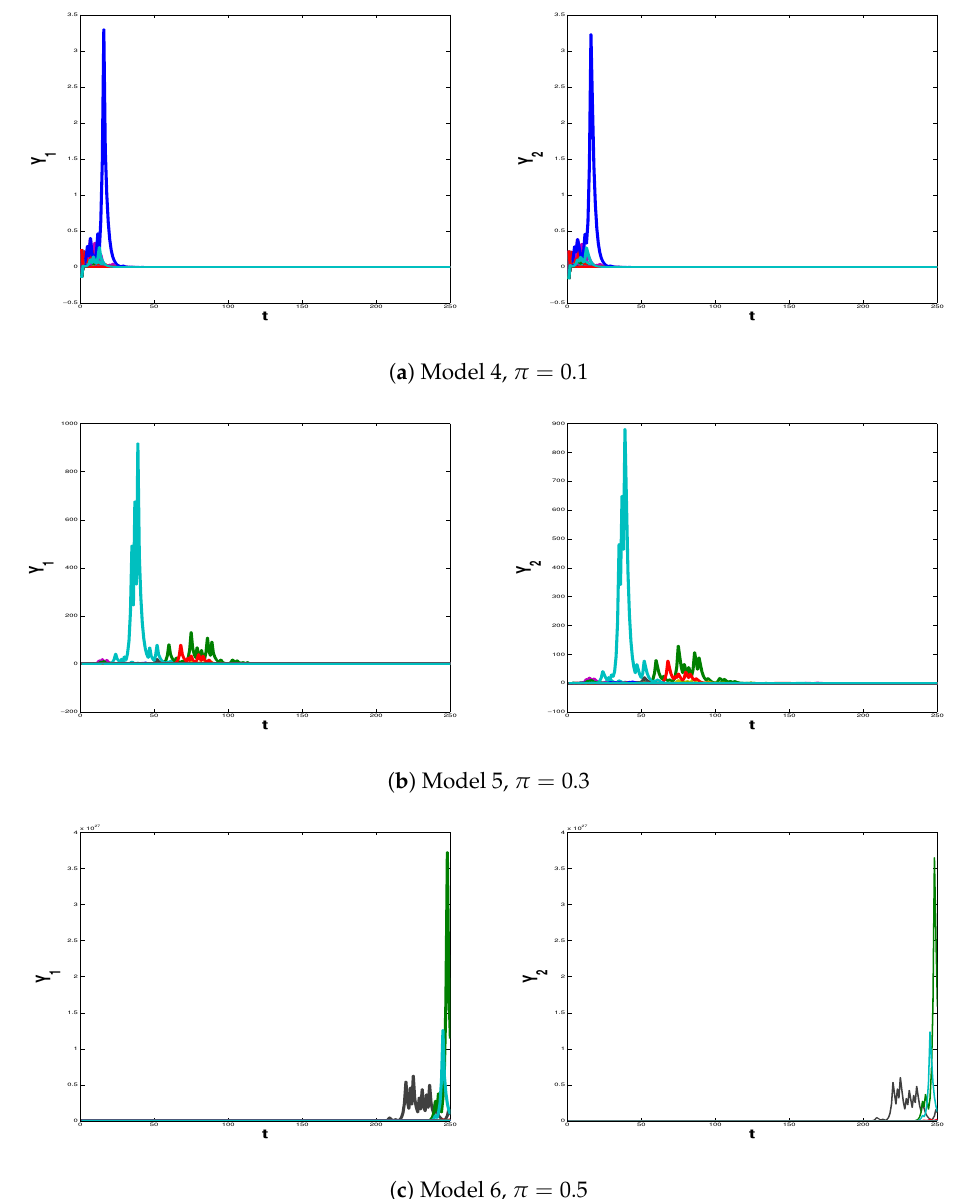
Figure 2. Simulated paths represented by different colors from models 4–6 for different set of histories over a n = 250 period using m = 200 simulated paths. The parameters are those from Table 1 and the probability to be in the explosive regime 2 is equal to π